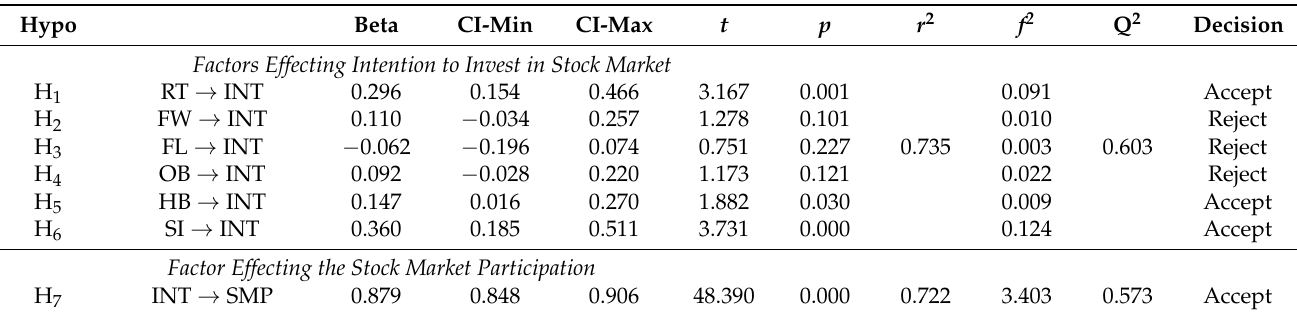
Table 5. Path Coefficients.